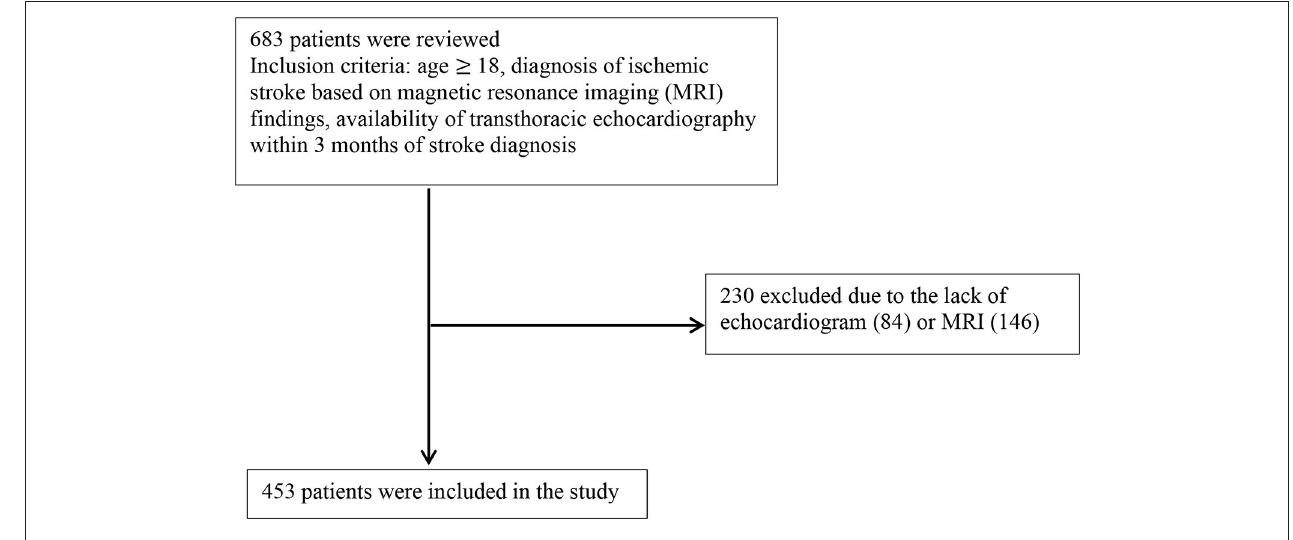
FIGURE 1 | Flow diagram for inclusion and exclusion criteria.